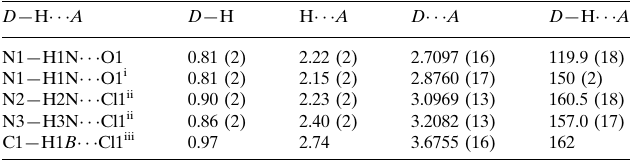
Hydrogen-bond geometry (A˚ , (cid:3)